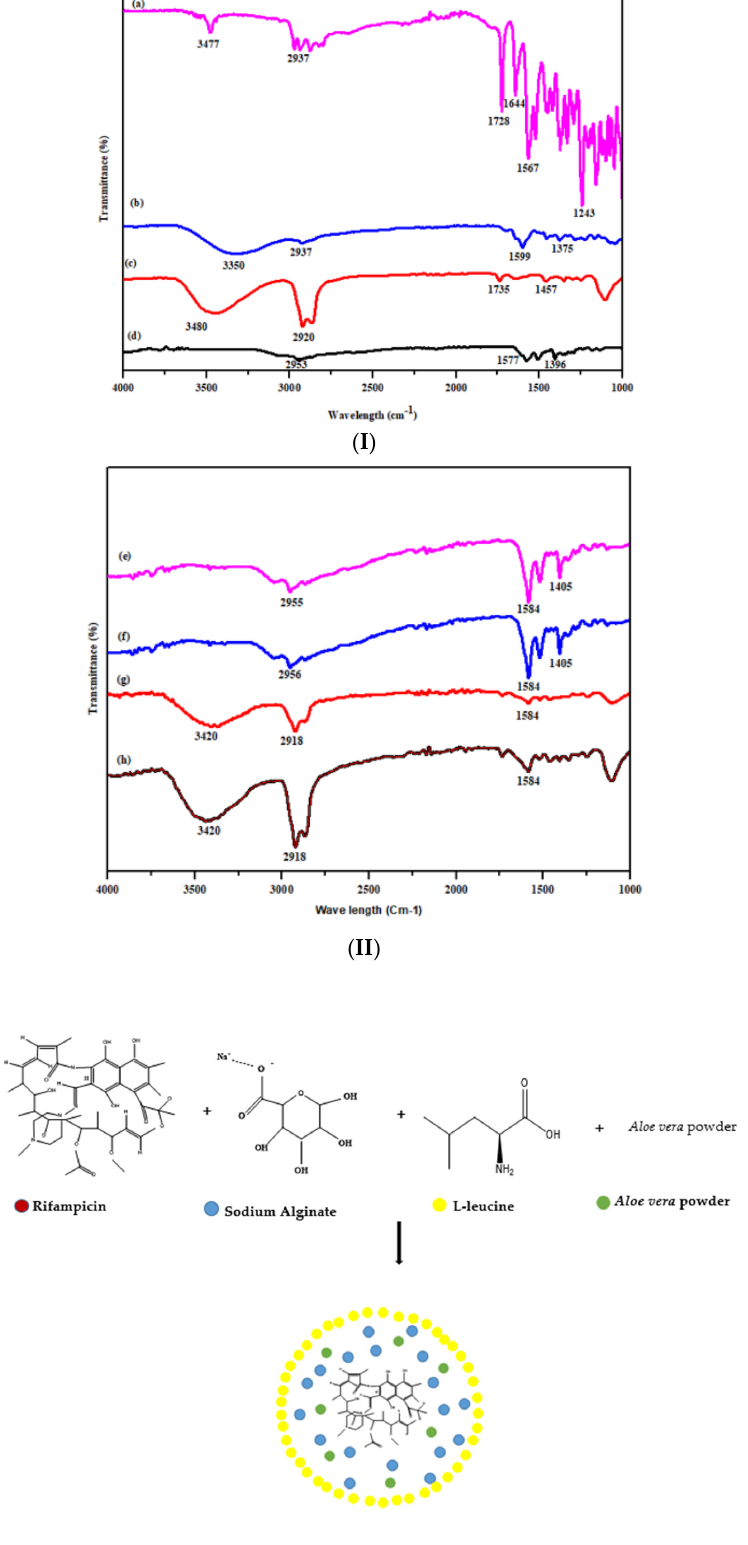
Figure 4. ( I ). FTIR Spectra of rifampicin (a), aloe vera (b), sodium alginate (c) and L-leucine; ( II ) (d) spray-dried microparticles formulations F4 (e), F5 (f), F6 (g) and F7 (h); ( III ) schematic representation of molecular structures of drug, carriers and spray-dried